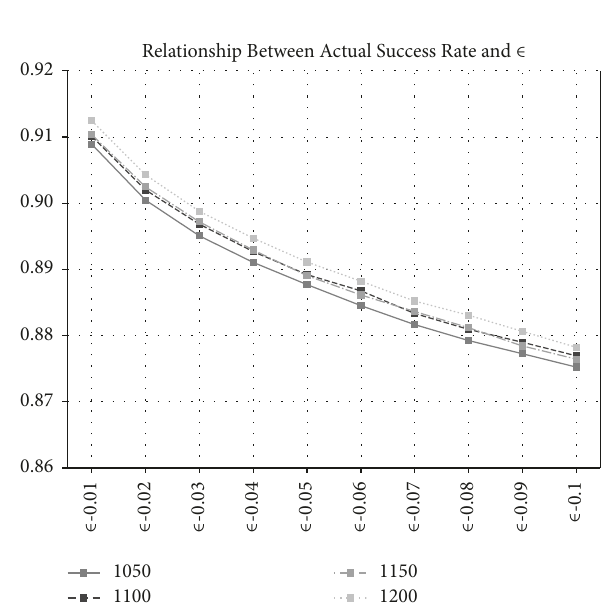
Figure 7: Relationship between the actual success rate and ϵ .